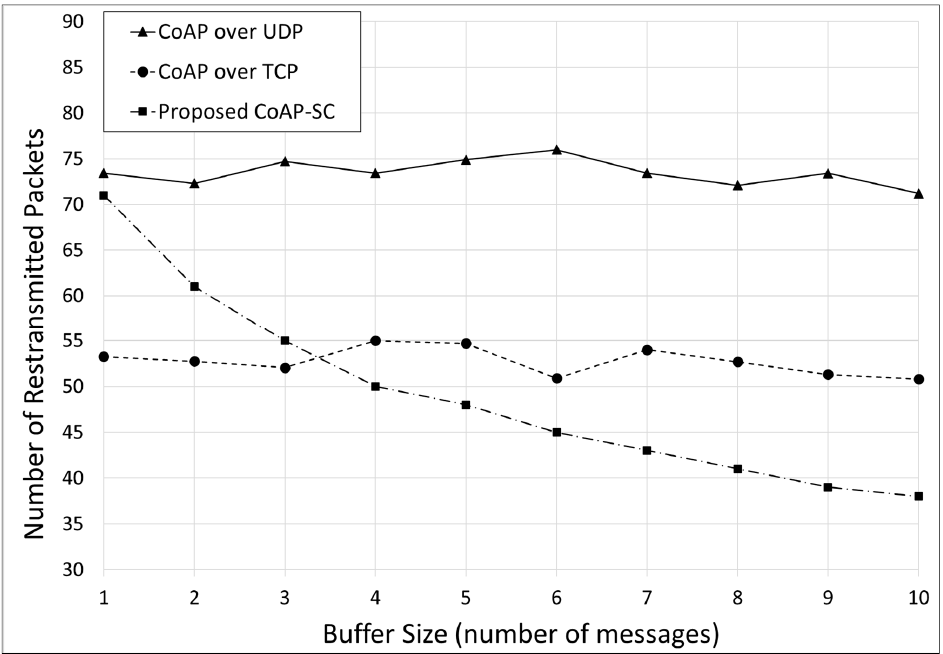
Figure 20. Number of retransmitted packets for different buffer size.